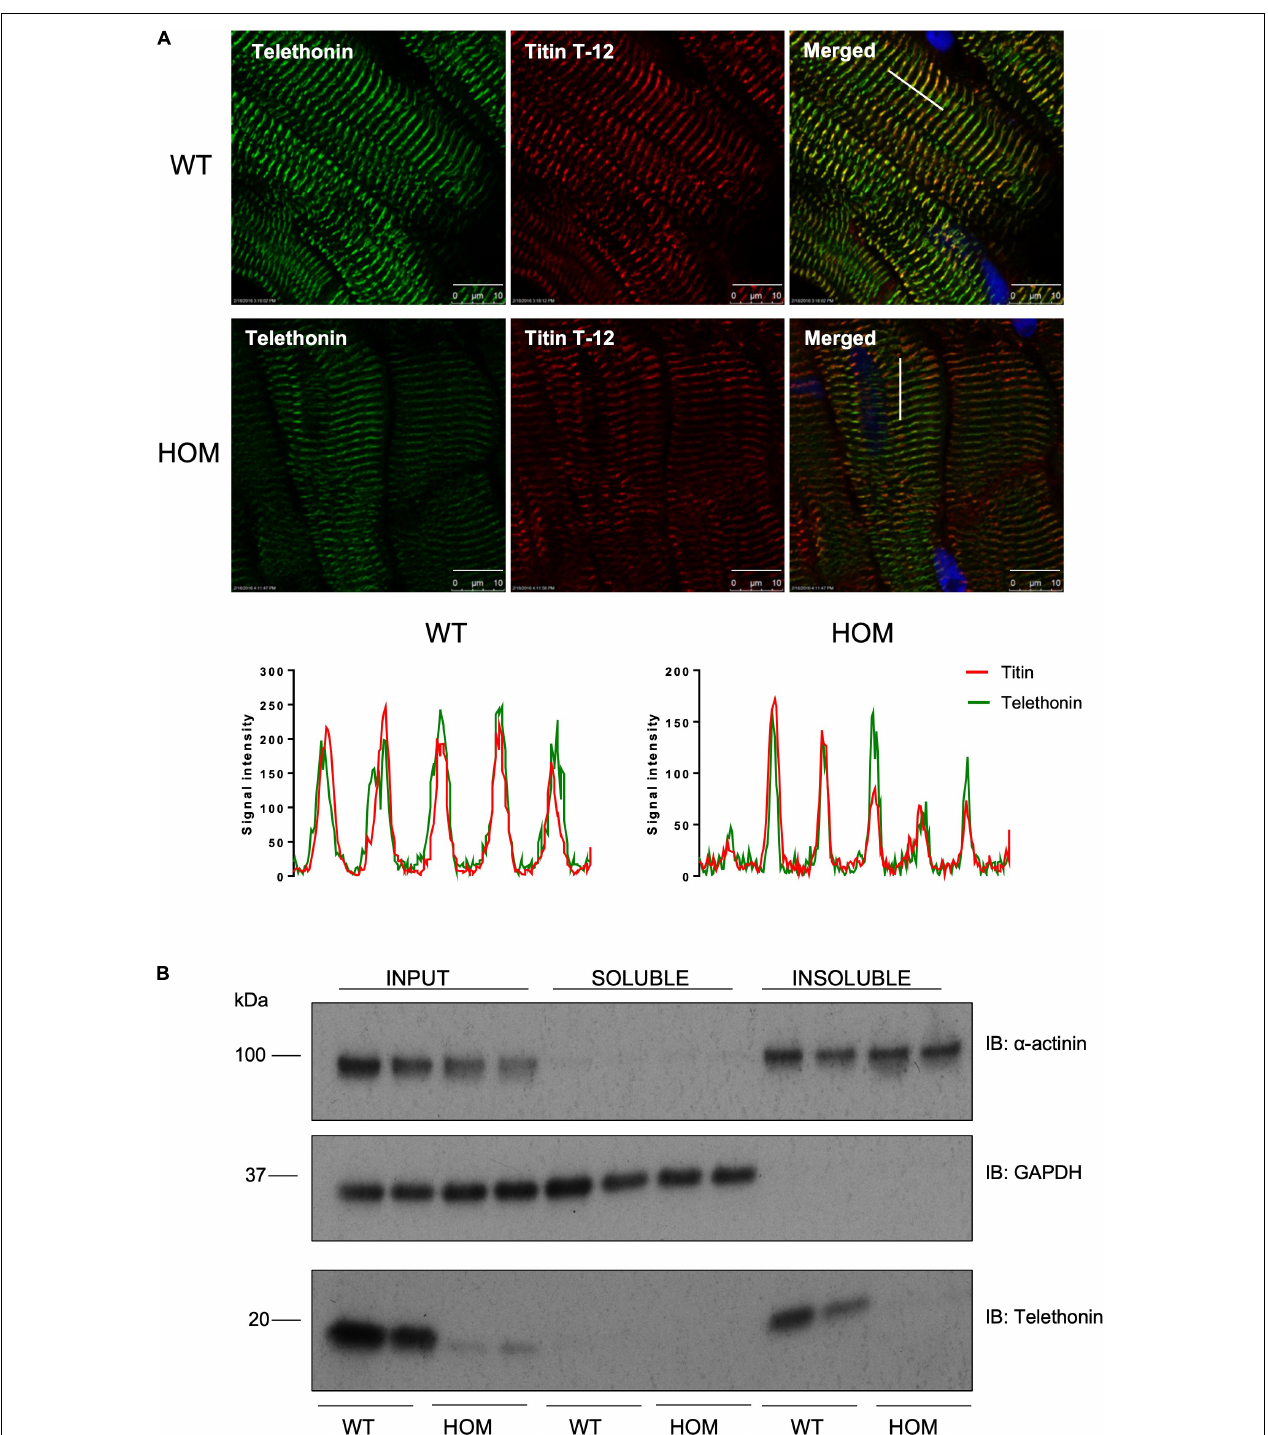
FIGURE 3 | Localization of telethonin in Tcap S157 / 161A KI mice. (A) Immunohistochemistry of cardiac tissue sections from 16 week male mice. Ten micrometers frozen cardiac tissue sections were immunostained with anti-telethonin/Alexa Fluor 488 (green) and anti-Titin N-terminal (Titin T-12)/Cy3 (red) antibodies ( n = 6). Scale bars are 10 µ m. Line charts indicate signal intensity traces of telethonin (green) and Titin T-12 (red), across the region shown by a white line shown on the merged images. (B) Distribution of telethonin between soluble and insoluble fractions of mouse heart homogenate in 16 week male WT and HOM mice. Samples were subjected to SDS-PAGE followed by immunoblotting with anti- α -actinin antibodies, as a marker of the insoluble myofilament fraction (upper panel), anti-GAPDH antibodies as a marker of the soluble fraction (middle panel) and anti-telethonin antibodies (lower panel).